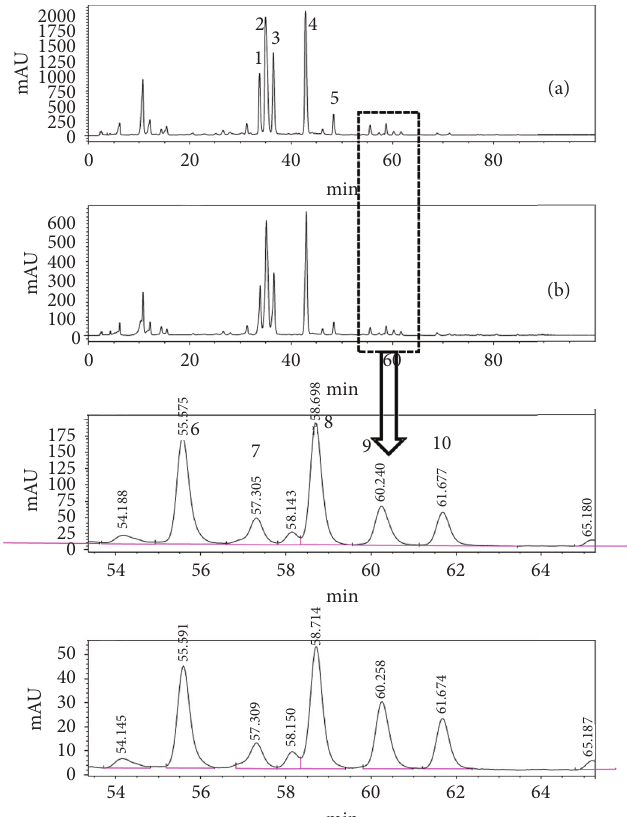
Figure 6: The chromatographic profiles of the 20% formic acid-methanol extract (a) and methanol extract (b) of Huangshan wild chrysanthemum decoction. Table 3: Retention time and peak area of Huangshan wild chrysanthemum decoction ( X ± S , n � 3).